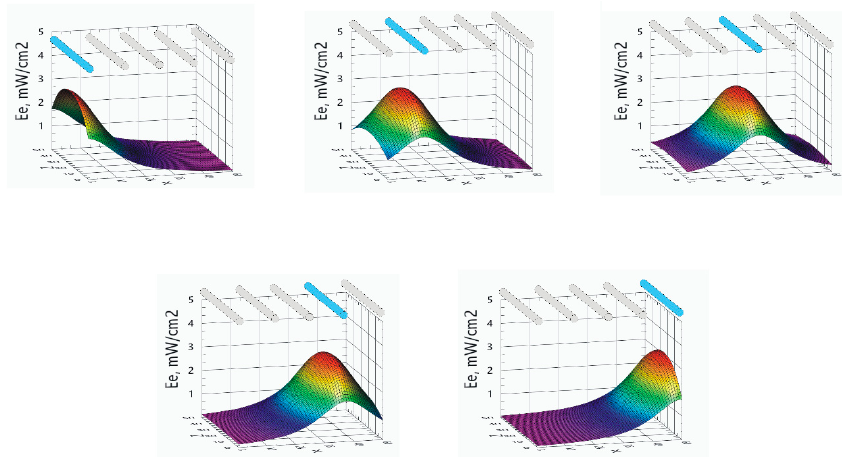
Figure 7. Spatial distributions of the direct radiation irradiance originating from a single active emitter.